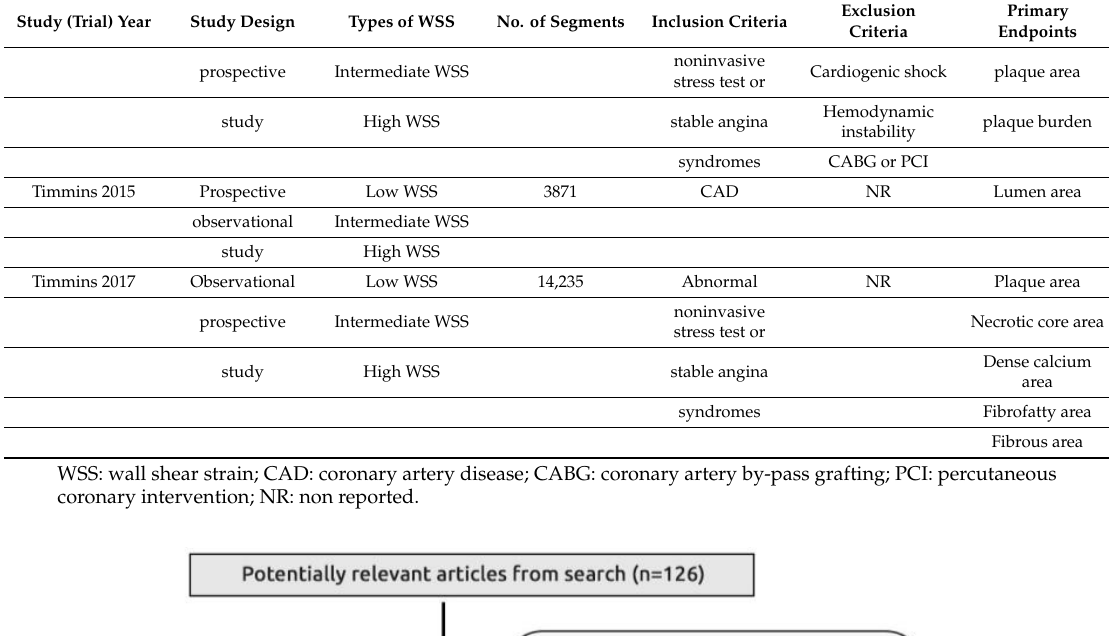
Table 2. Main characteristics of patients enrolled among trials included in the study.